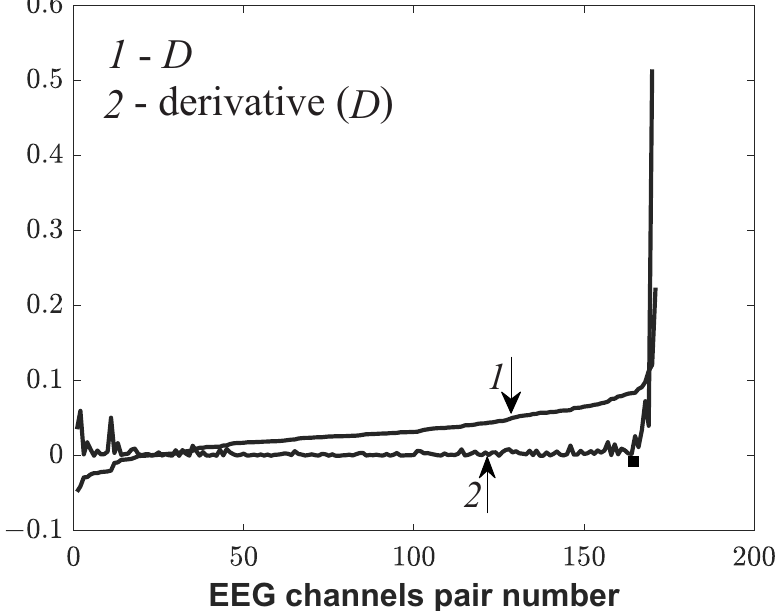
Figure 13. The dependence of D sorted in increasing order (line1) versus the numbers of a pair of EEG channels and its derivative (line 2) for a control subject in the CT1